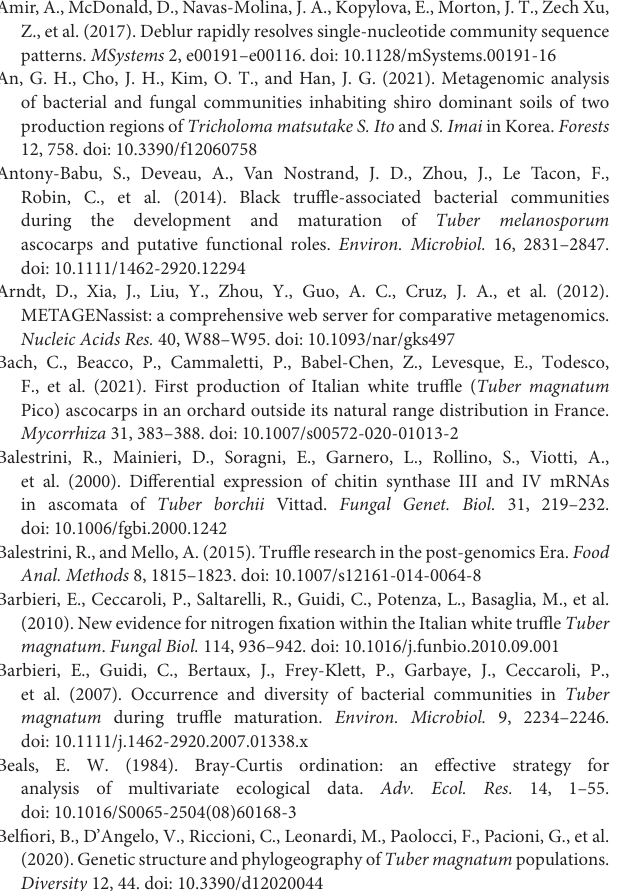
Supplementary Figure S1 | Rarefaction curves of samples grouped according to sample condition. The horizontal axis indicates the sequences amount getting from Illumina the number of sequences obtained through the Illumina MiSeq sequencing platform on V3–V4 regions. The vertical axis shows the number of operational taxonomic units (OTUs), at a level of 99% sequence similarity, which approximates the number of identified bacterial species. Supplementary Figure S2 | Variation in Flavobacterium abundance among different soil and truffle samples. Boxplots represent abundance (filtered and log-transformed count) of the taxa in the four tested conditions.